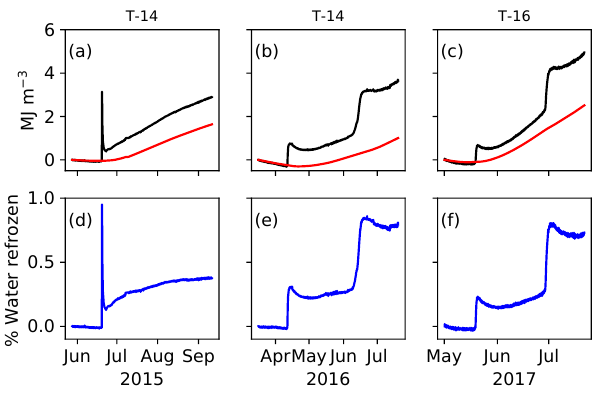
Figure 7. Energy source for the observed heating events. (a–c) Ob- served energy density through time for the differenced temperature profile calculated with Eq. (9) (black) and conductive energy den- sity through time calculated with Eq. (10) (red). (d–f) Percentage by volume water refrozen for the associated source in (a–c) . This value is proportional to the difference between the black and red lines above. The temperature string from which measurements were taken is labeled at the